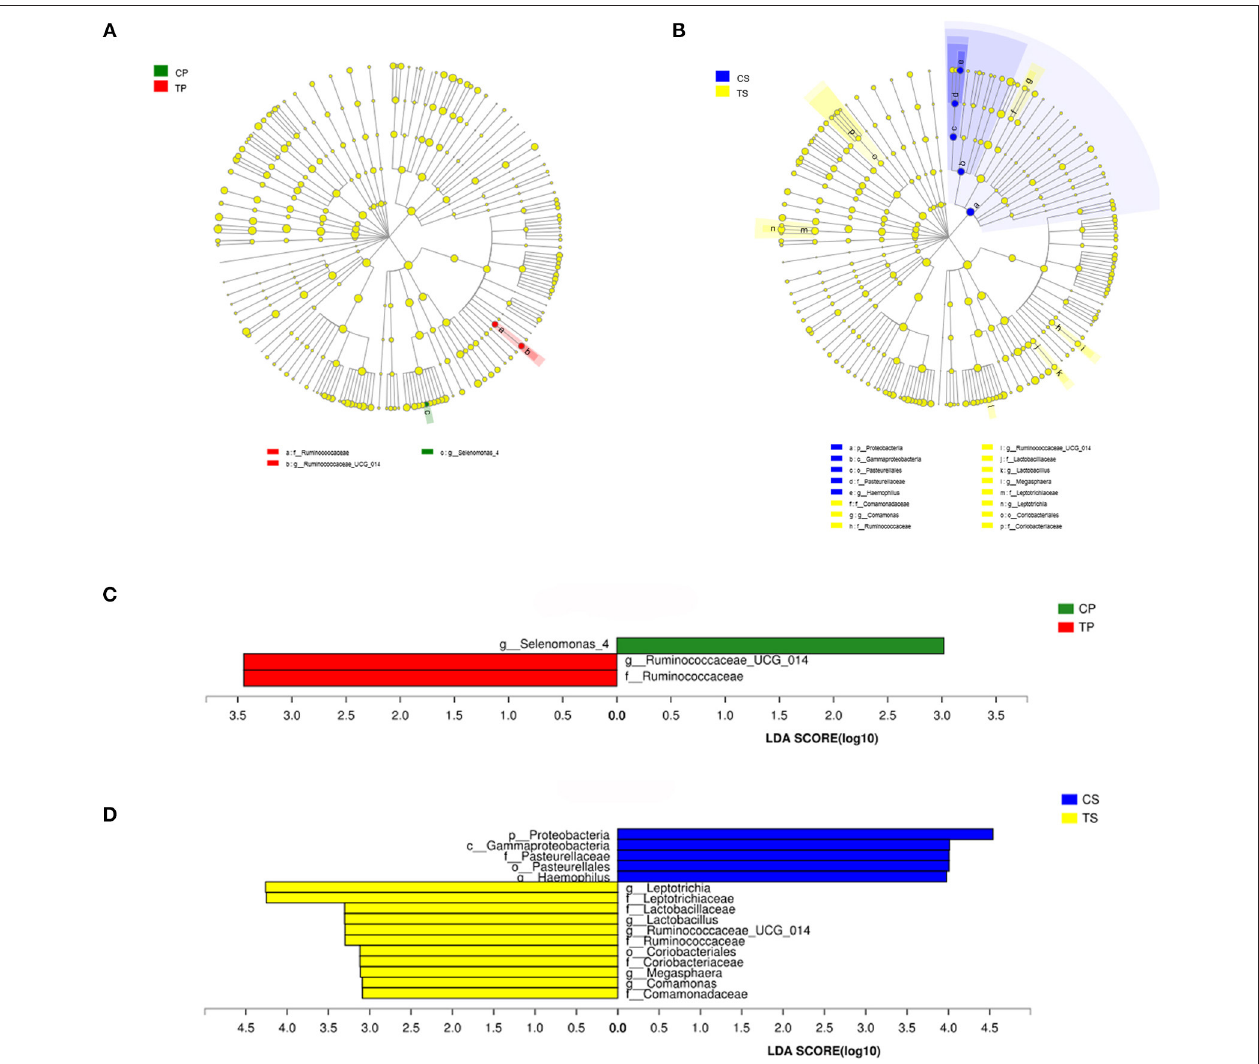
FIGURE 6 | The potential biomarkers were defined by LEfSe. (A,B) Cladogram for taxonomic representation of significant differences between caries-active and caries-free groups. The colored nodes from the inner to the outer circles represent taxa from the phylum to genus level. The significantly different taxa are signified by different colors representing the four groups. (C,D) Histogram of the LDA scores for differentially abundant features among groups. The threshold on the logarithmic LDA score for discriminative features was set to